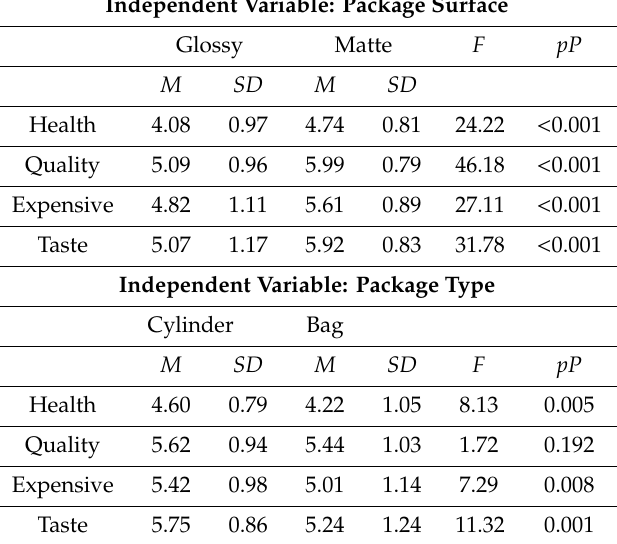
Table 2. The e ff ect of package surface and package type on higher-level evaluations: Descriptions and test